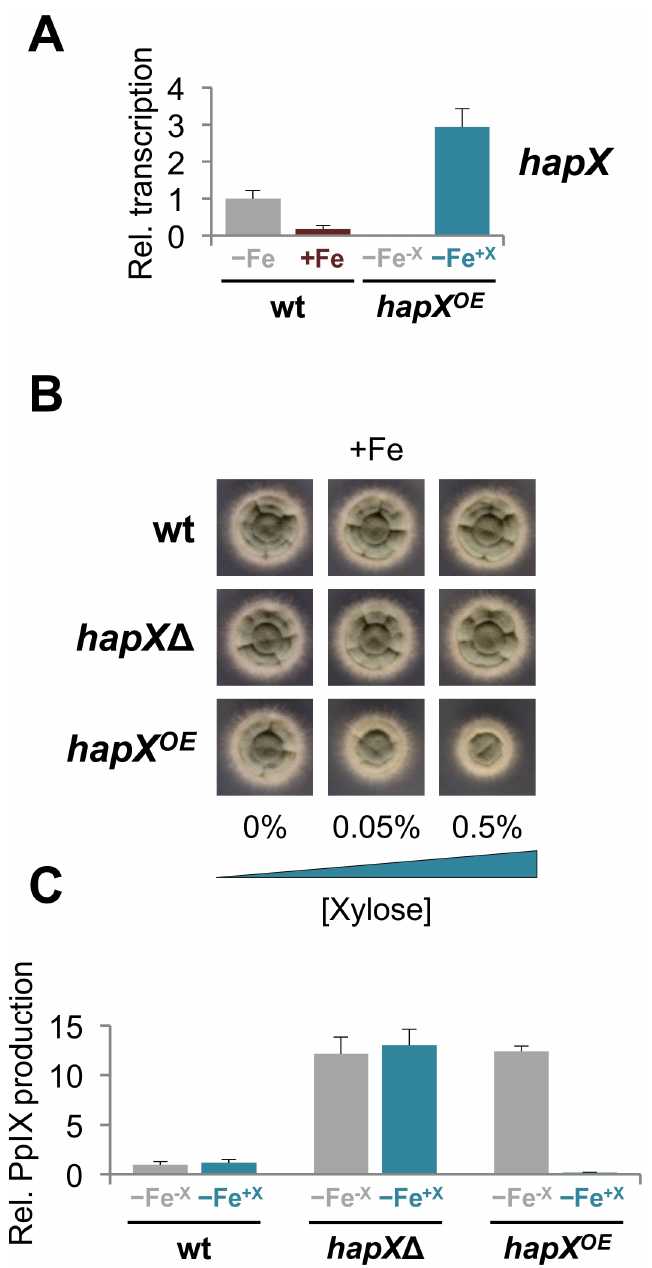
Figure 10. Overexpression of hapX affects growth and PpIX production. ( A ). Quantitative real- time reverse transcription RT-qPCR. Samples were obtained from the wild-type strain grown under − Fe and +Fe conditions as in Figure 2A, and from hapX OE grown in − Fe conditions as in Figure 2A ( − Fe -X ) and then supplemented with 0.01% xylose for 15 min ( − Fe +X ). Transcript levels of the indicated genes, normalized to actA , are expressed relative to those obtained in the wild-type strain in − Fe. Bars represent standard deviations from two independent biological experiments with two technical replicates each. ( B ). Growth of the indicated strains on solid AMM +Fe (30 µ M FeSO 4 ) with the indicated concentration of xylose (%). Plates were incubated for 2 d at 37 ◦ C. ( C ). Quantification of PpIX in − Fe conditions with or without 0.05% xylose. PpIX levels of the indicated strains were normalized to the amount of total protein and expressed relative to those in the wild-type strain in the absence of xylose. Bars represent standard deviations from two independent biological experiments with two technical replicates